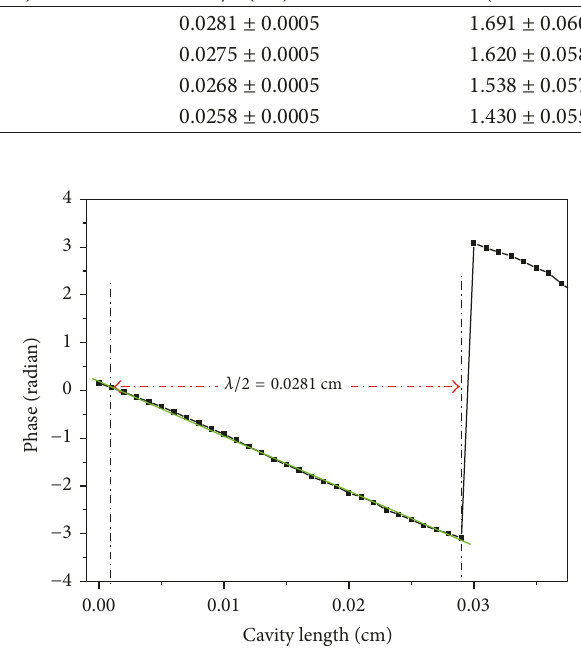
Figure 6: Variation of the PE signal phase as a function of cavity length for different instrumental reference phase. Plots correspond- ing to different instrumental phase reference phase are shifted from each other.